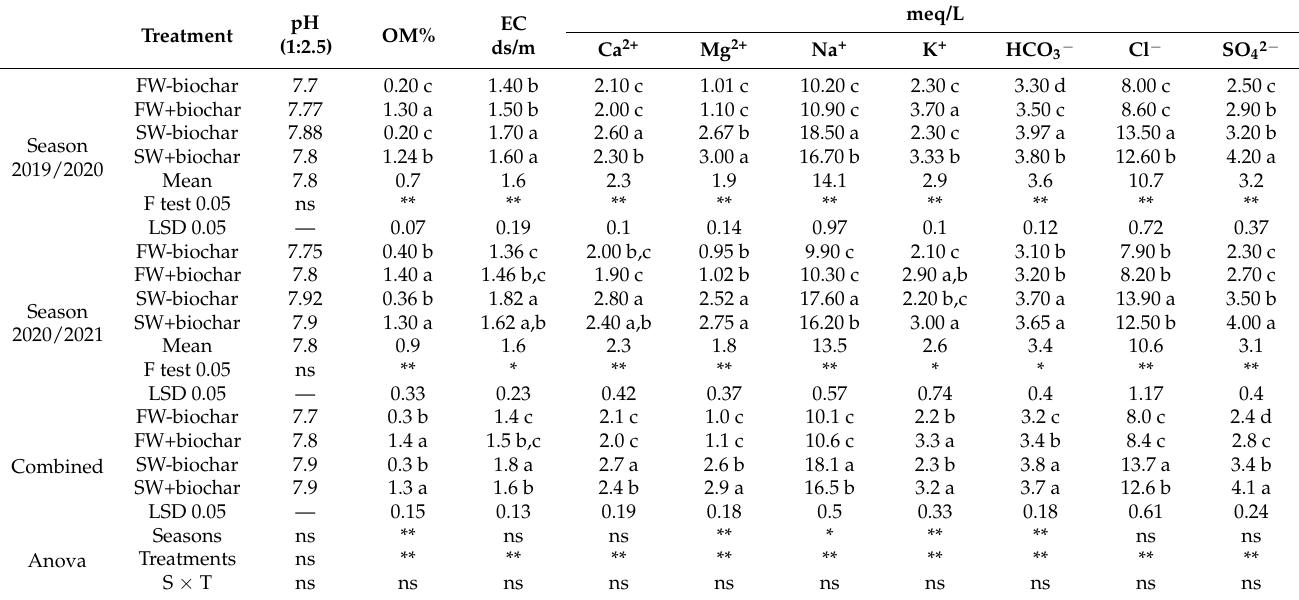
Table 5. Some properties of soil samples of study seasons 2019/2020 and 2020/2021 after harvest time.